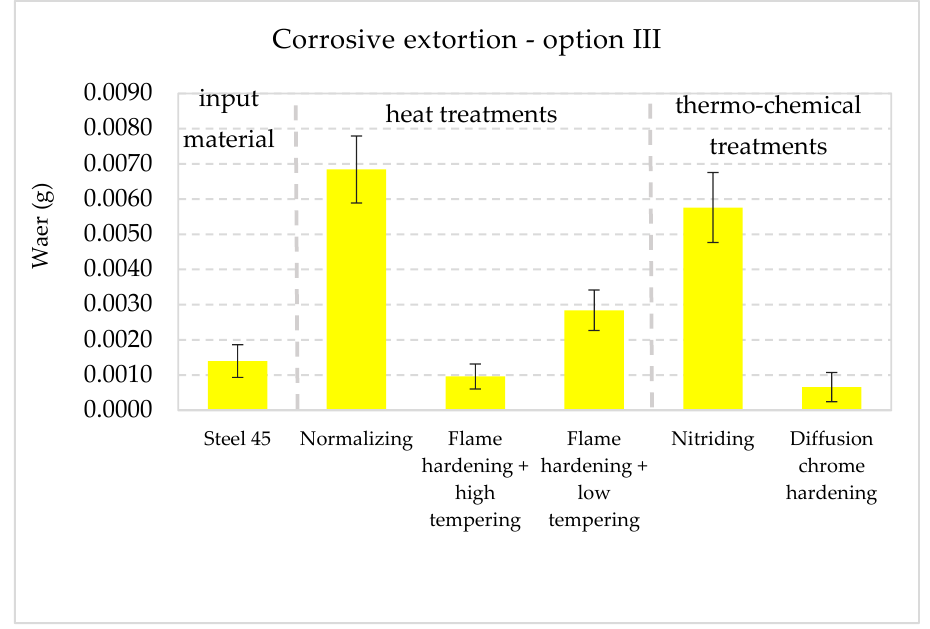
Figure 15. Wear I C values in the conditions in corrosive extortion (no action from mechanical and abrasive agents) with 90% confidence semi-intervals [40].